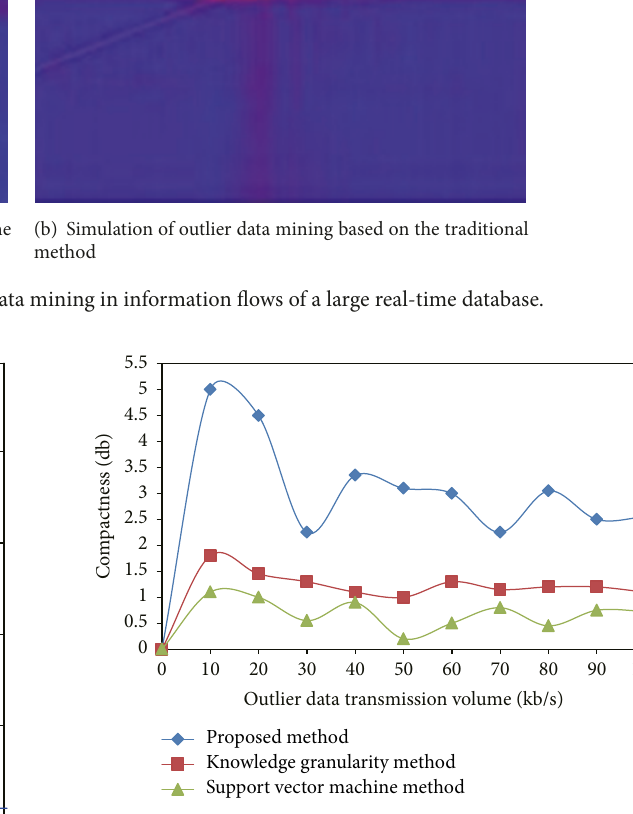
Figure 11: Comparison of outlier data mining compactness.